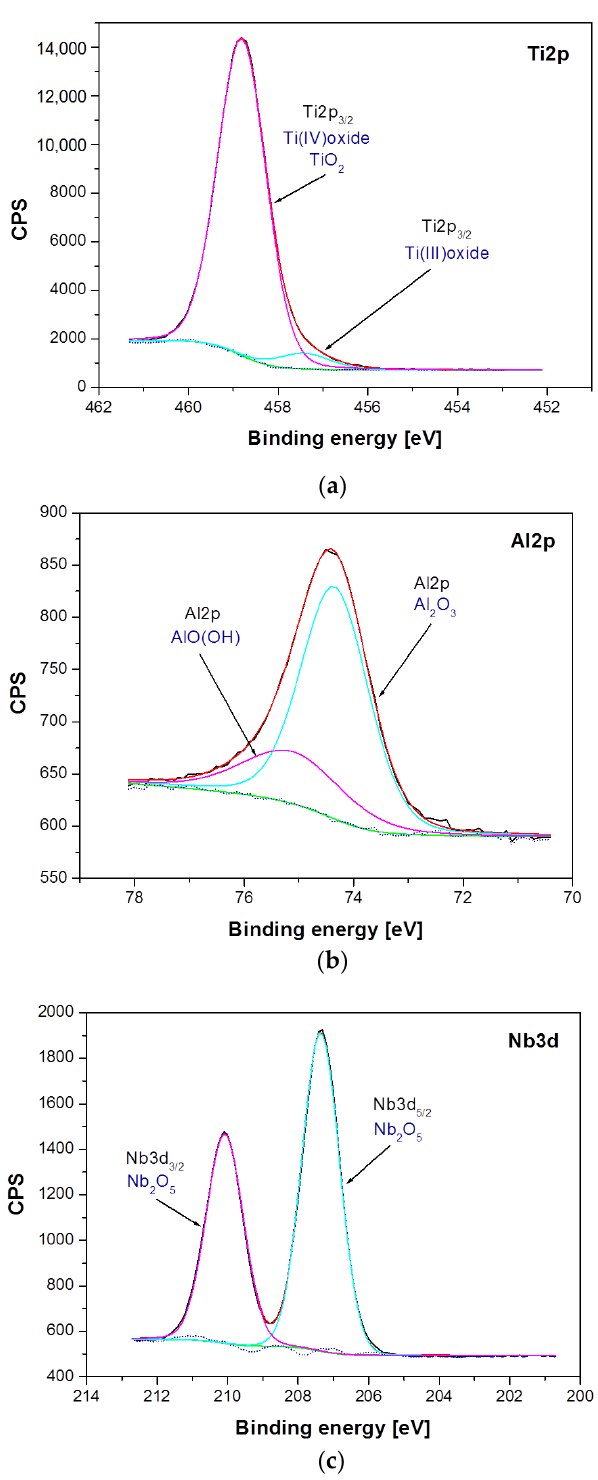
Figure 5. High-resolution XPS spectra for the photoemission line: ( a ) Ti2p; ( b ), Al2p and ( c ) Nb3d, obtained for the Ti – 6Al – 7Nb alloy in the initial state.